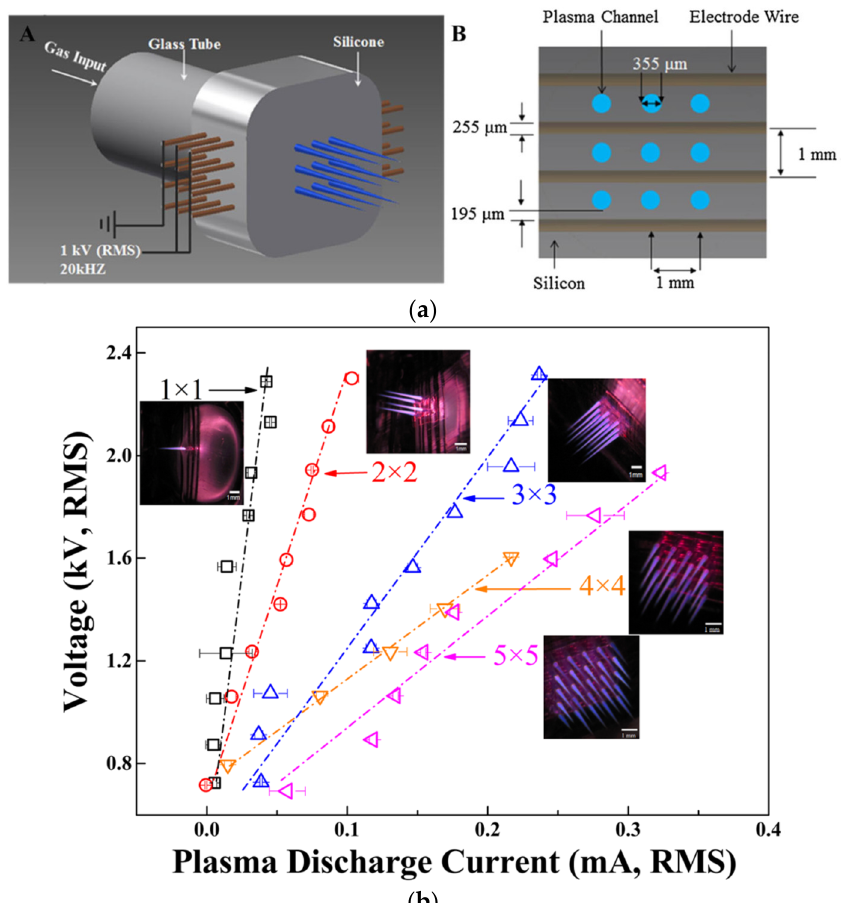
Figure 5. ( a ) Schematic representation of the close-packed microplasma multi-jet source fabricated using a flexible silicone structure. The general view ( A ) and front view ( B ) show the nozzle arrangement with relevant distances. ( b ) V-I characteristics of different micro-APPJ square matrices. Reprinted/adapted with permission from Ref. [41]. Copyright 2015, John Wiley & Sons, Ltd.